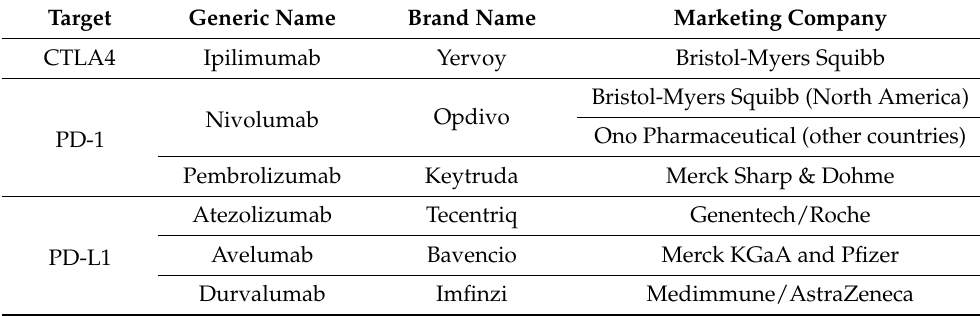
Table 2. Key trials with ICIs, targeted therapies, and antibody-drug conjugates.